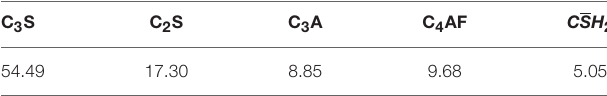
TABLE 2 | Mineral composition of the ordinary portland cement